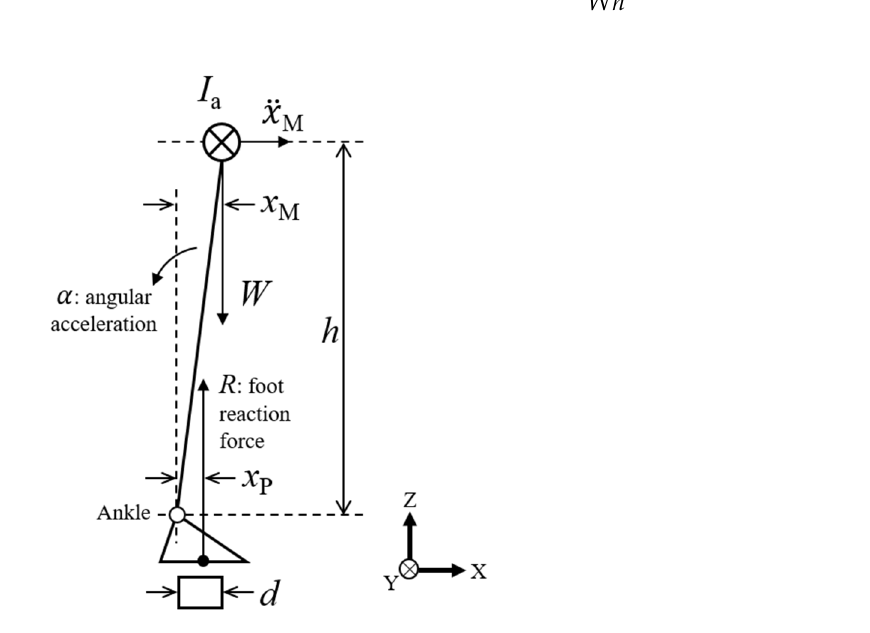
Figure 1. The inverted pendulum model of the human body on a restricted platform in the sagittal plane.